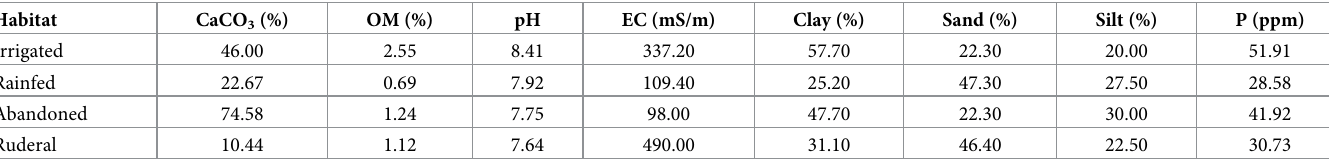
Table 2. Soil properties of seed collection sites. Habitat CaCO 3 (%) Irrigated Abandoned Ruderal OM = organic matter, P = phosphorus, EC = electrical